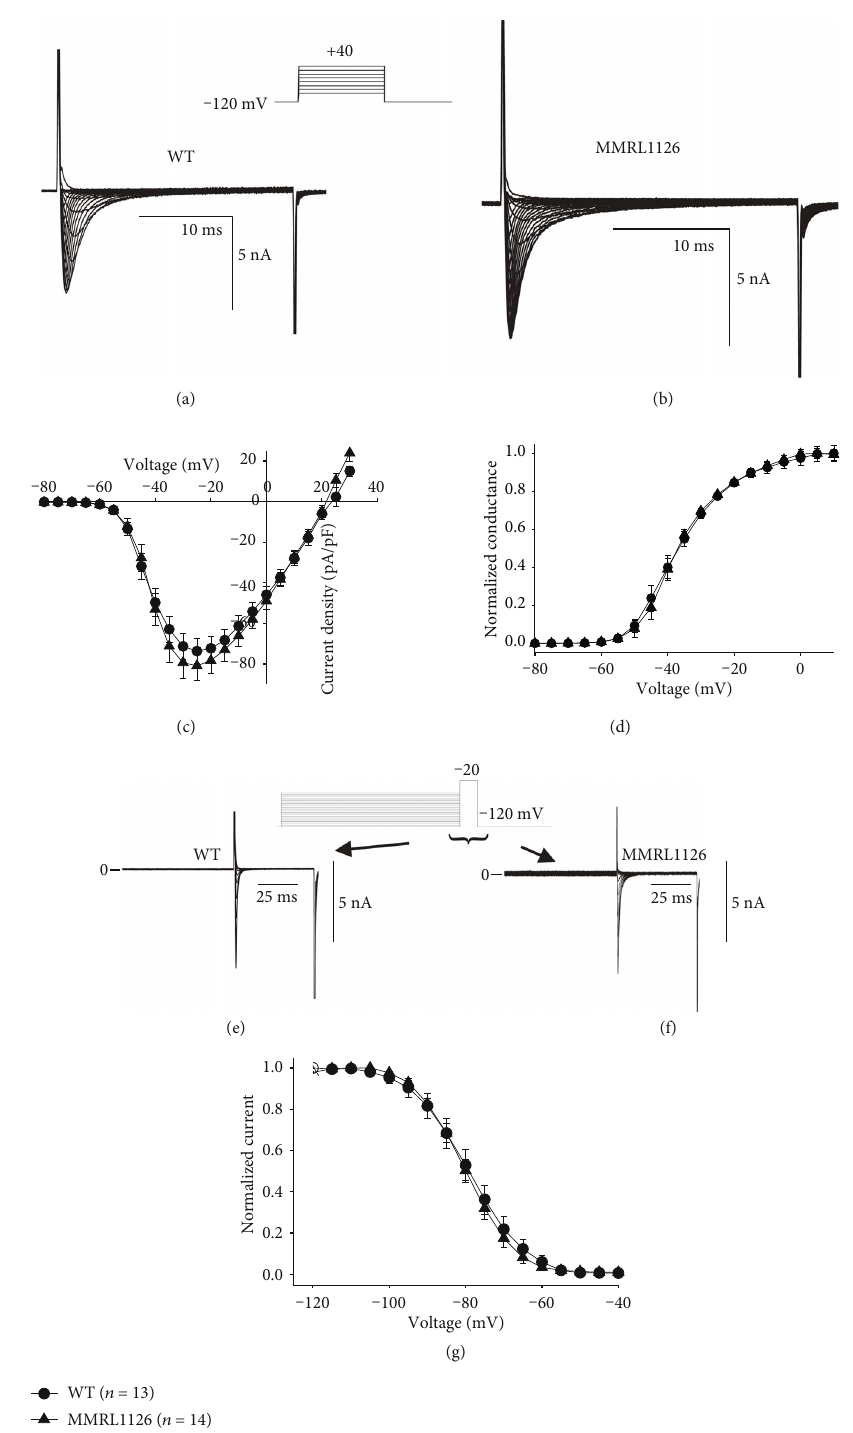
Figure 6: Representative I recordings from a WT (a) and MMRL1126 hiPSC-CM (b). Current recordings were obtained at test potentials Na between − 80 and 25 mV in 5mV increments. The holding potential was − 120mV. (c) I – V relation for WT ( n = 13 ) and MMRL1126 ( n = 14 ) showing no di ff erence in I magnitude. (d) Steady-state activation relation for WT and MMRL1126 hiPSC-CM cells. Chord conductance Na was determined using the ratio of current to the electromotive potential for the cells shown in (a) and (b). Data were normalized and plotted against their test potential. Representative steady-state inactivation recordings from a WT (e) and MMRL1126 hiPSC-CM (f). The voltage clamp protocol is shown at the top of the fi gure. Peak current was normalized to their respective maximum values and plotted against the conditioning potential. The mean data for the steady-state inactivation relation is shown